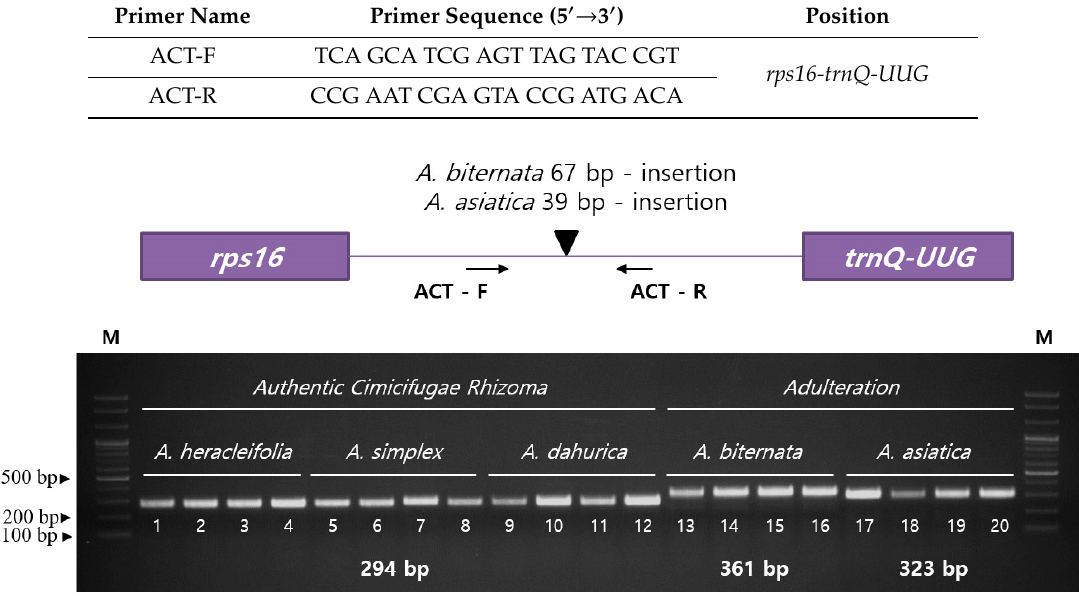
Table 2. Primers used to develop the Actaea (ACT) indel marker.